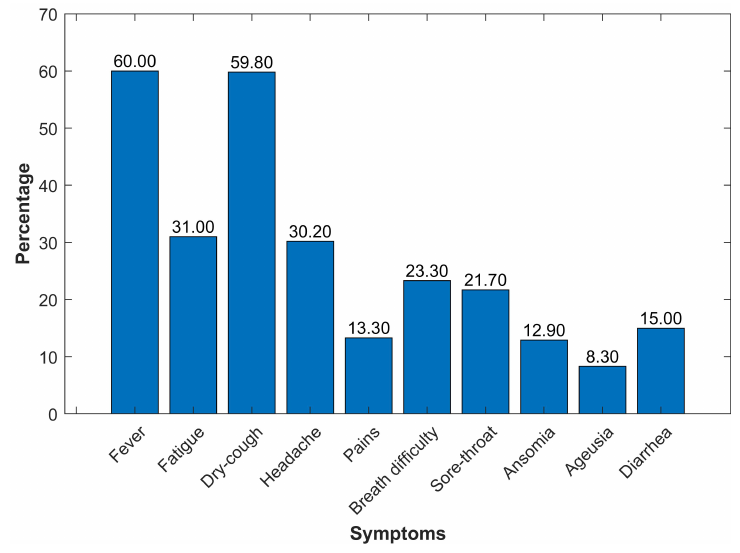
Figure 4. Distribution of symptoms found in COVID-19 patients. Table 1. COVID-19 symptoms values for positive and negative